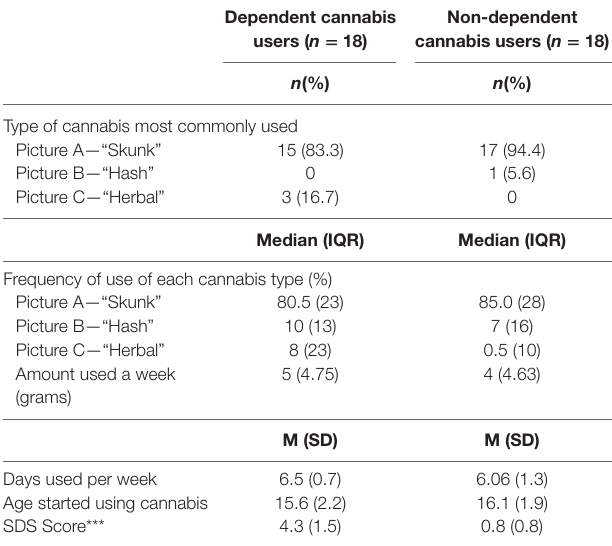
Table 2 | Cannabis use in the cannabis groups.